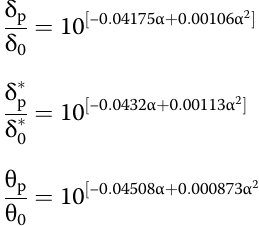
The suction side boundary layers expressions for non-zero angle of attack and untripped condition are given